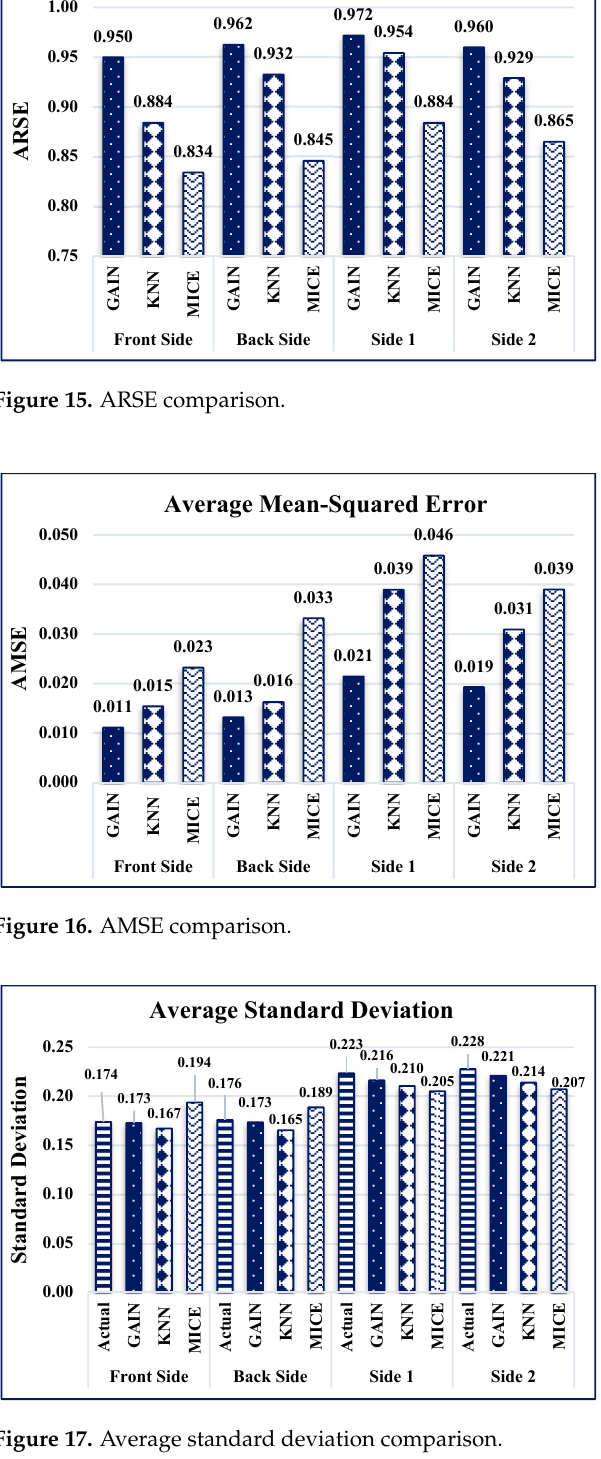
Figure 18. Average variance comparison. The comparison of the original pressure values and the imputed pressure values of the MICE, KNN, and GAIN models at different pressure tap locations for all four sides of the building is depicted in Figure 19. It is clearly shown that the GAIN predicted average pro- duces closer imputed values with the actual values when compared with MICE and KNN.